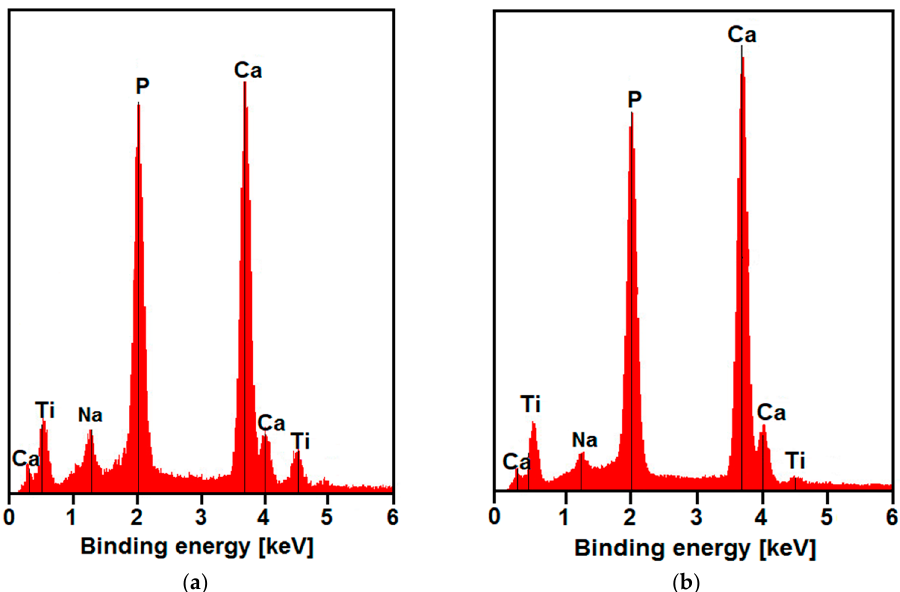
Figure 11. EDS spectrum after 7 days of immersion in SBF at 36.6 °C: ( a ) CpTi G4 substrate; ( b ) CaP coating deposited at − 3 V for 30 min at 20 °C.